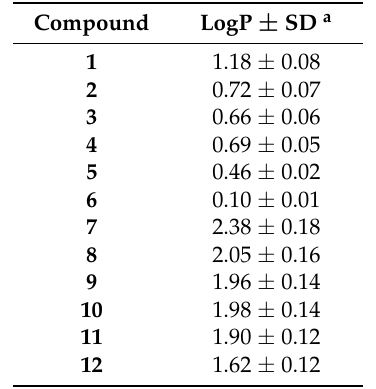
Table 1. LogP values of compounds 1 – 12 .